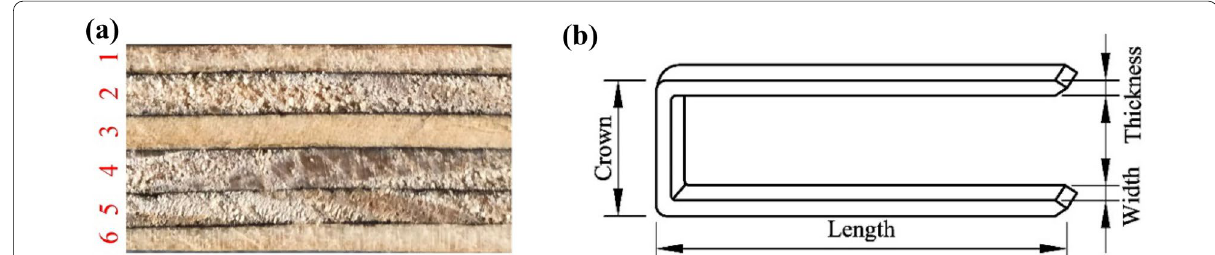
Fig. 1 Picture ( a ) and diagram ( b ) showing different orientations of plies in plywood and detailed dimensions of staples used in this study, respectively